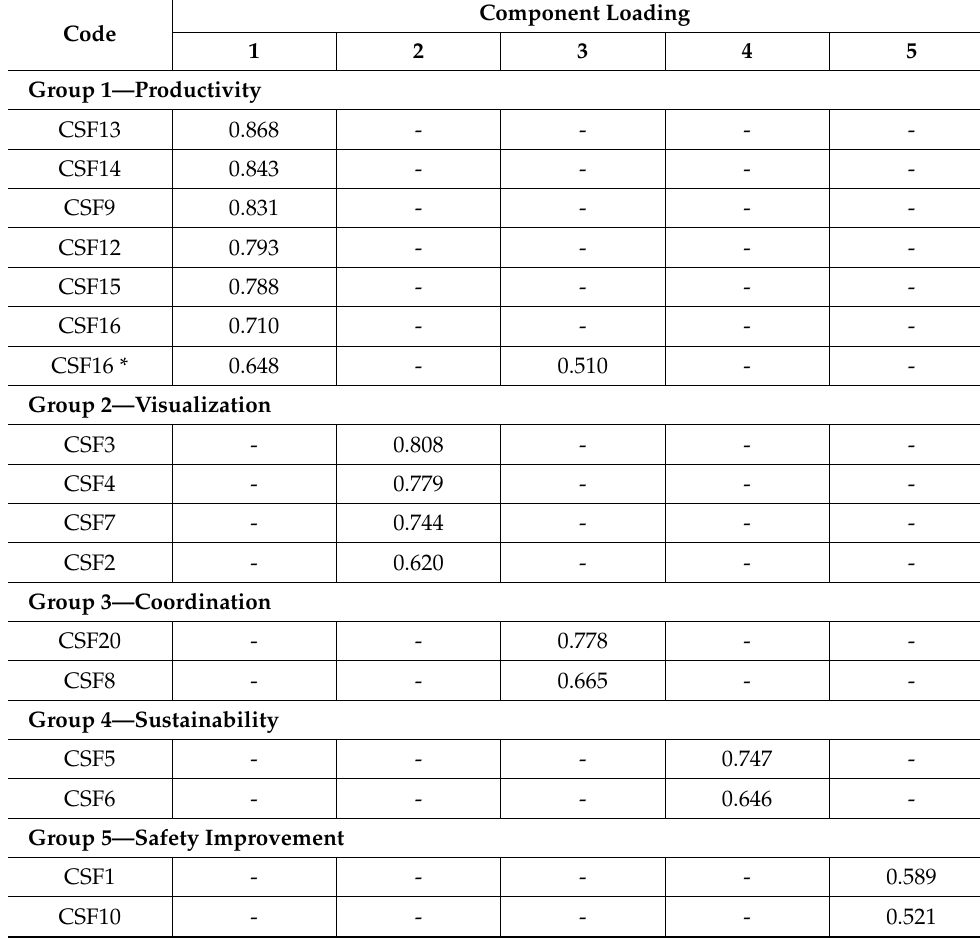
Table 4. Factor loading after rotation in exploratory factor